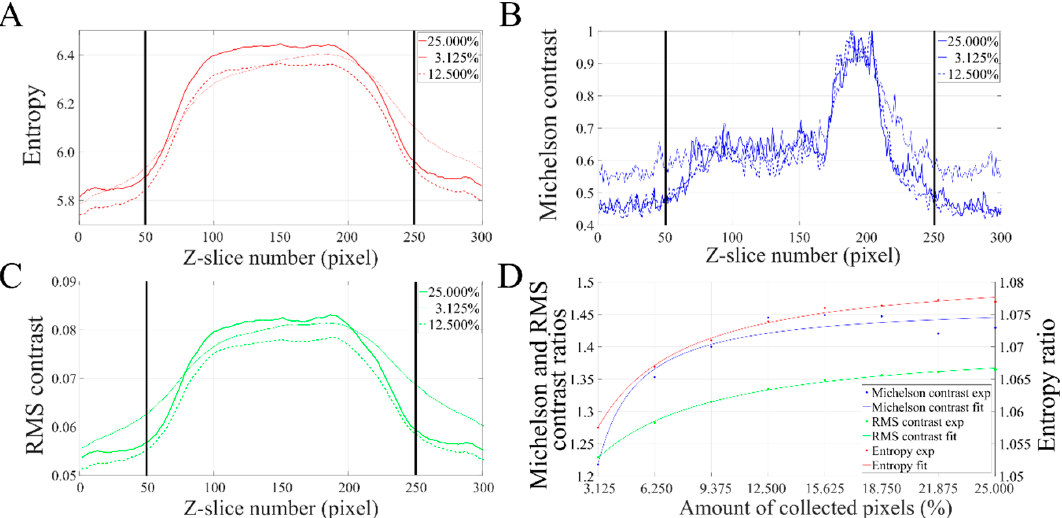
Figure 6. Image quality descriptors (IQD) values of sparse reconstructions depending on the amount of downsampling. ( A – C ) Plots of the H , C m and C rms descriptors computed at each Z slice of three reconstructions (3.125%, 12.5% and 25%), respectively. Thick vertical lines mark the location of the resin section in the reconstructed volumes (between Z-slices 50 and 250). ( D ) IQD ratios (experimental values and fitted curves) plotted by increasing order of